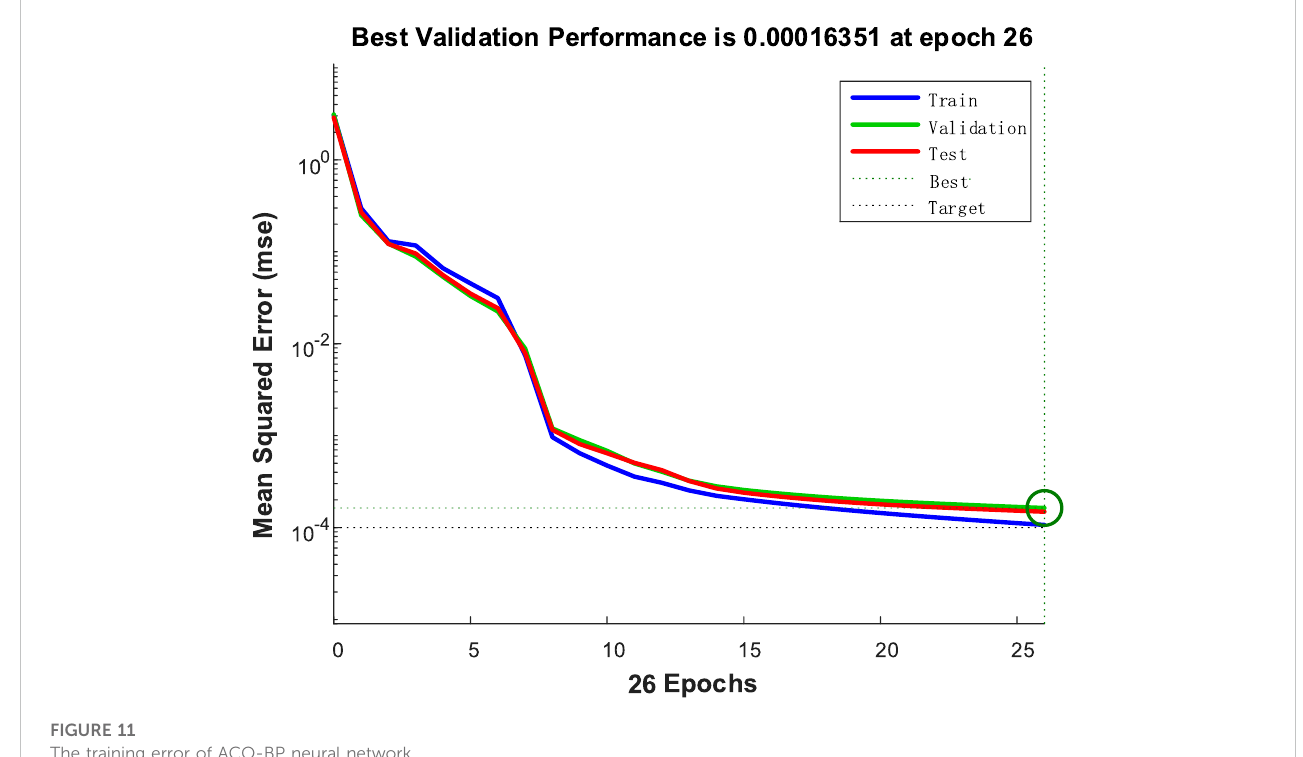
FIGURE 11 The training error of ACO-BP neural network.